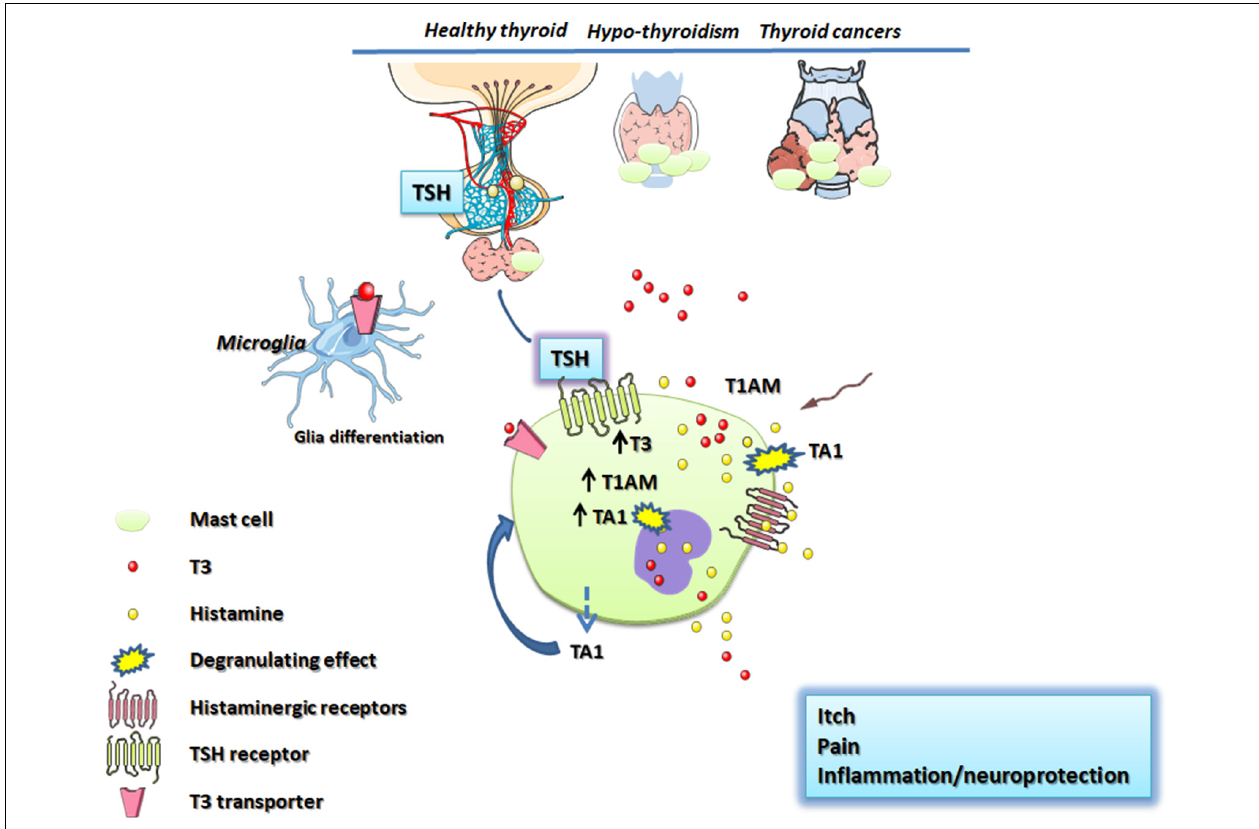
FIGURE 1 | Schematic representation of thyroid and mast cell connections. The hypothalamus, throughout the release of the TSH, stimulates mast cells increasing the T3 content. T3 is co-stored with histamine in mast cell granules or is degraded to T1AM and/or TA1. T1AM and TA1 derived from circulation or produced inside mast cells trigger mast cell degranulation releasing T3 and histamine which mediates pain, itch and central effects including neuroprotection/neuroinflammation. Thyroid stimulating hormone (TSH); TSH receptor (TSHR); thyroid hormones (T3, T4); 3-iodothyronamine (T1AM); 3-iodothyroacetic acid (TA1); monoamine oxidases